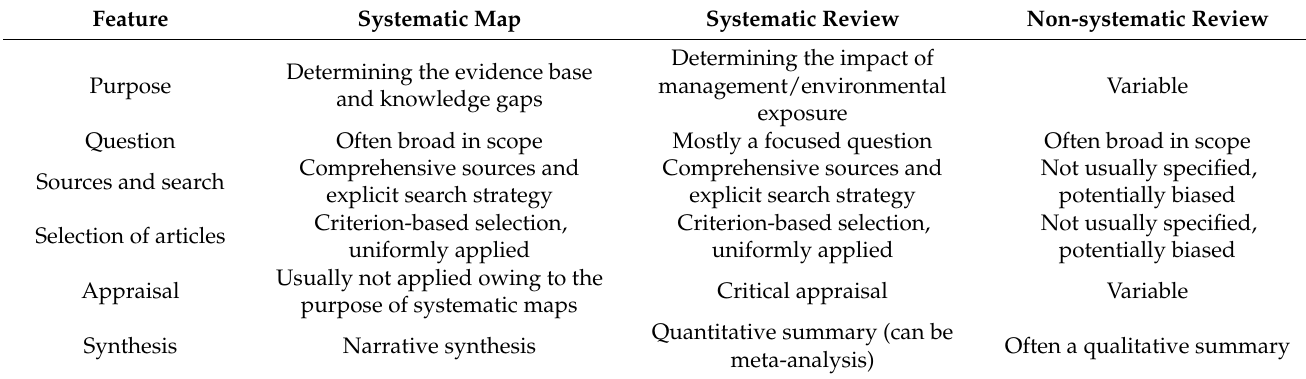
Table 1. Differences between systematic maps, systematic reviews, and traditional, non-systematic literature reviews (adapted from Petrokofsky 2017